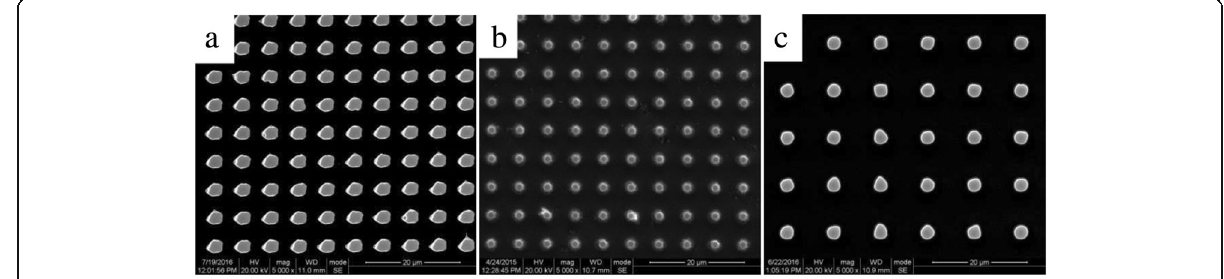
Fig. 3 Typical microstructured silicon arrays made by DRIE for different mask sizes. a Mask I. b Mask II. c Mask